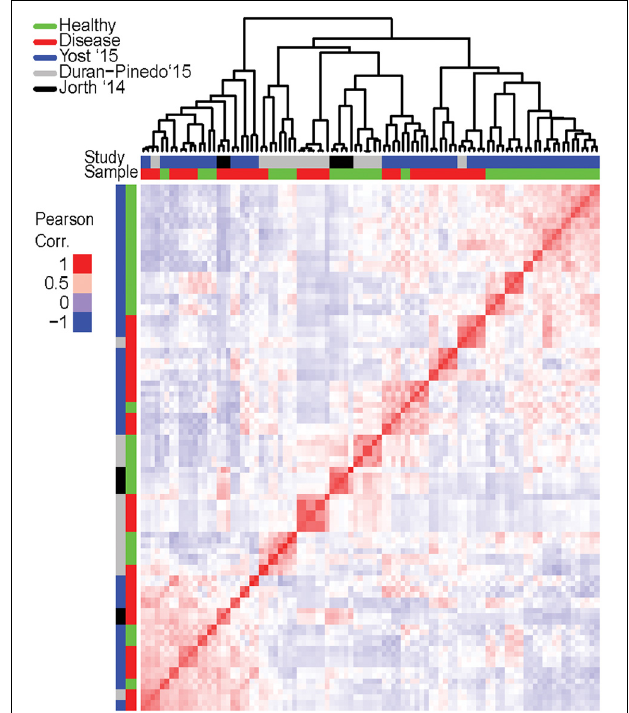
FIGURE 2 | Correlation in expression of differentially expressed (DE) transcripts among individual samples. Expression of the DE transcripts (from the pooled dataset) was calculated for in each individual sample and the pair-wise correlation between samples based on these transcripts computed and a heatmap generated to represent the correlation. Red is high correlation (PCC = 1) while blue is a negative correlation (PCC = -1). Clustering of samples based on the similarity in expression is represented on top (since this is a pairwise comparison, only the column dendrogram is represented). Samples are further annotated by state – disease or healthy, and by origination study. Clustering of disease samples across different origination studies based on expression is not observed. Possible clustering of samples based on the origination study suggests inherent differences between studies and may be attributed to many variables such as inclusion criteria, disease progression, or sampling and sequencing